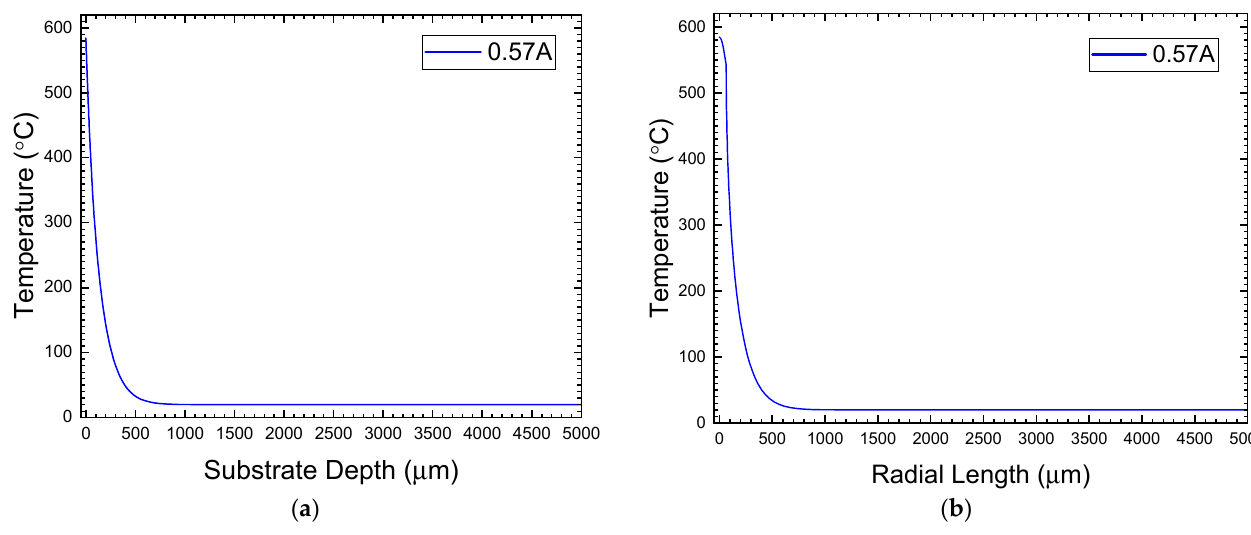
Figure 6. The estimated temperature of the substrate in the ( a ) vertical and ( b ) parallel directions from the printed line after electrical sintering using SCIS techniques. The figures show the case with final-step current of 0.57 A, which produced the highest temperature.